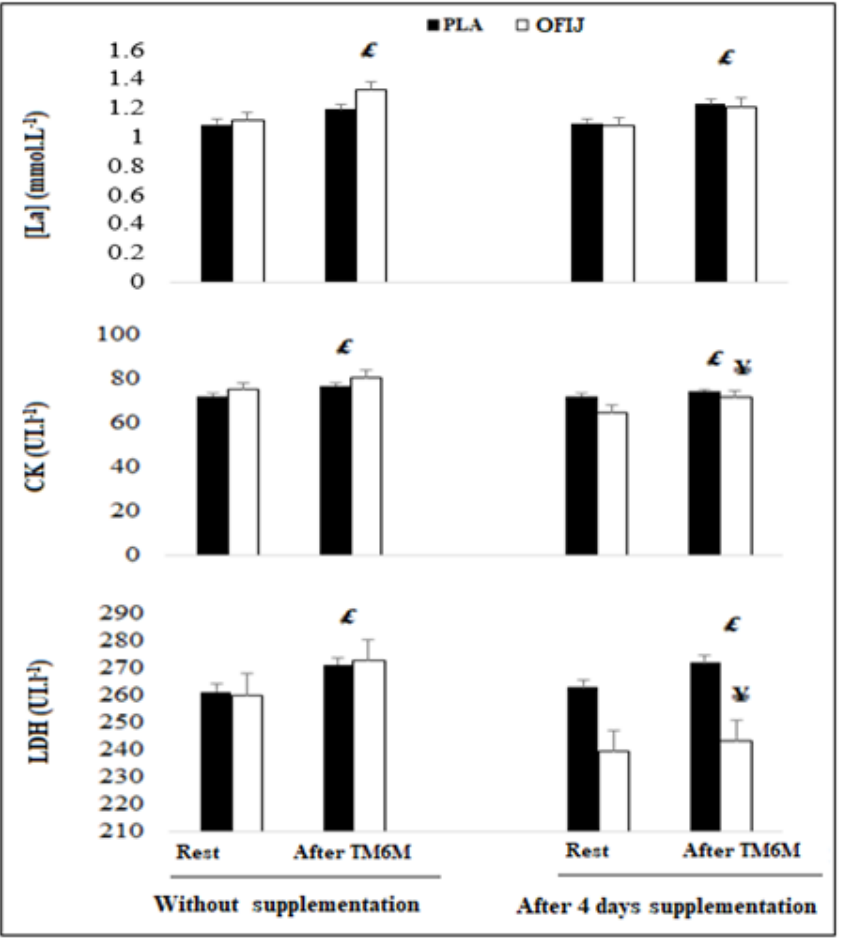
Figure 6. Muscle-damage markers (mean ± SD; n = 20) recorded before and after the 6MWT during without and with supplementation of PLA and OFIJ. £: significant difference compared to before the 6MWT ( p < 0.05). ¥: significant difference compared to without supplementation ( p < 0.05).